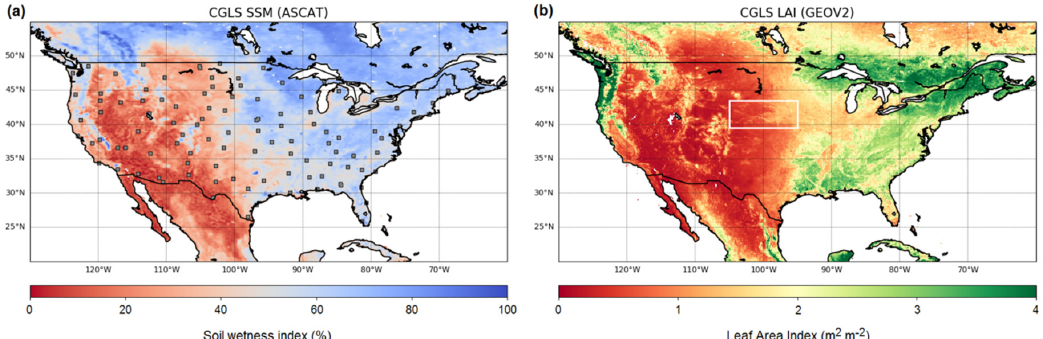
Figure 1. Average values of Copernicus Global Land Service (CGLS) soil wetness index (SWI) from combined ( a ) Advanced Scatterometer (ASCAT) observations and ( b ) CGLS leaf area index (LAI) observations from the GEOV2 dataset. Individual points on ( a ) are locations of U.S. Climate Reference Network (USCRN) in situ observations. The rectangle in ( b ) is the domain used to analyze LAI and corn yield over the state of Nebraska.